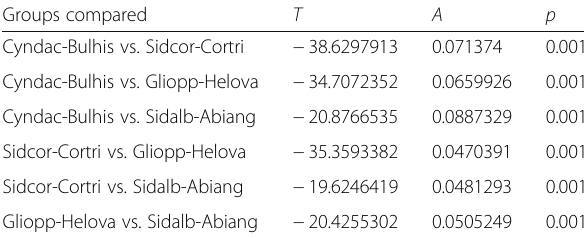
Table 1 A multi-response permutation procedure (MRPP) pairwise comparison for the species communities.